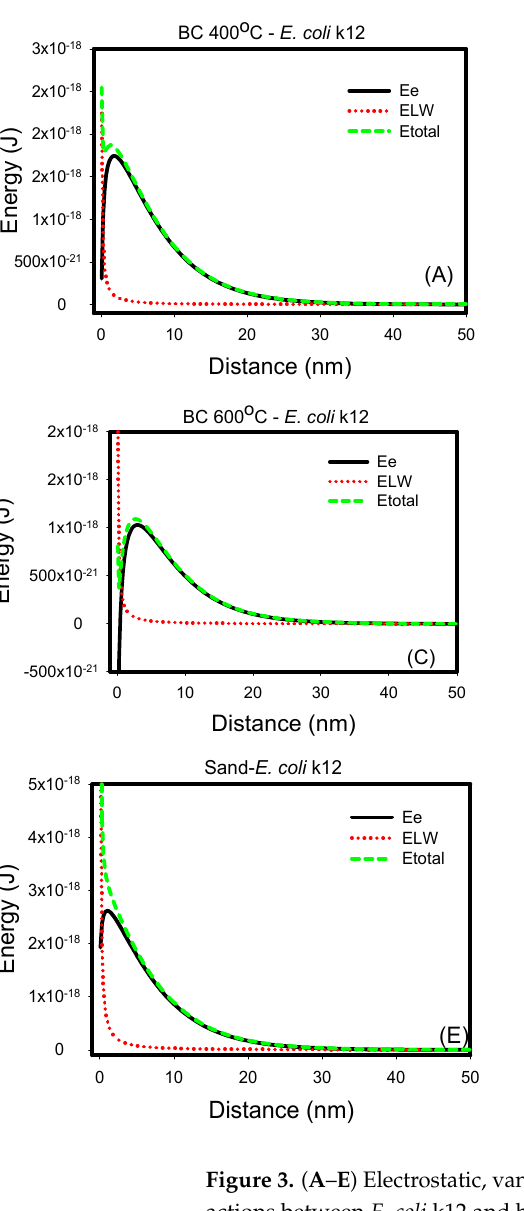
positive energy values. On the contrary, these interactions were attractive with biochar 700 ◦ C as indicated by the negative energies. Similarly, when the electrostatic energies were considered, the interactions with E. coli k12 were all repulsive (sand and biochars 400, 600, and 700 ◦ C). They were attractive with biochar 500 ◦ C.